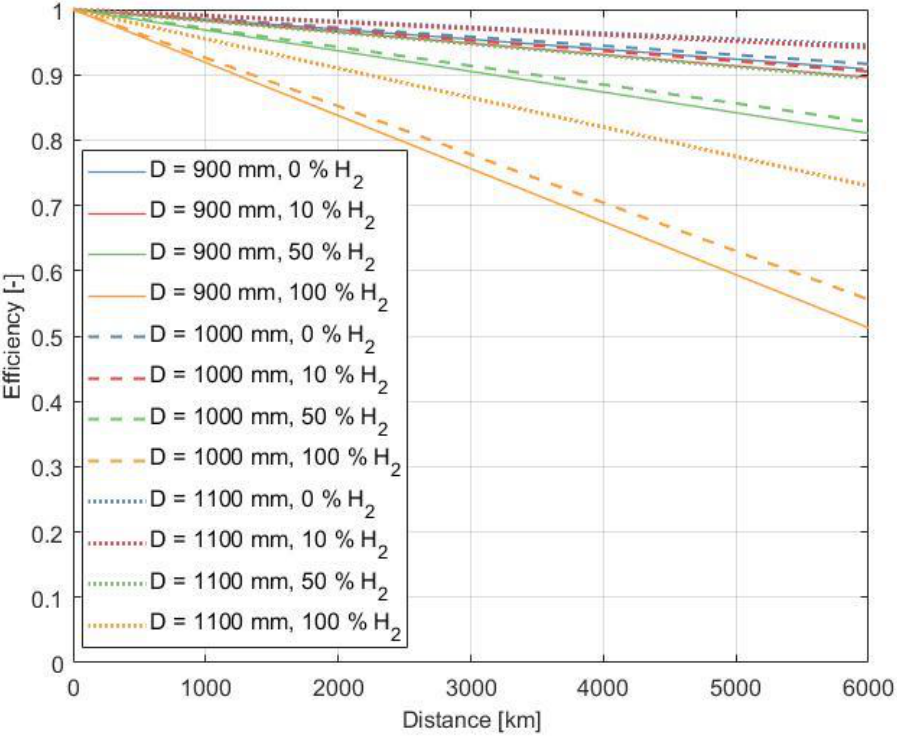
Figure 11. Influence of pipe diameter on transport efficiency.